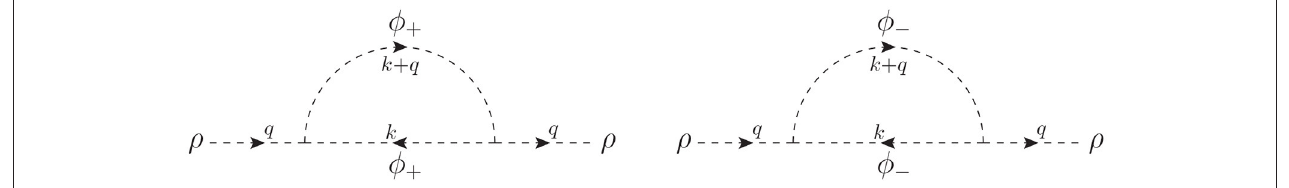
FIGURE 1 | One-loop contributions to the self-energy of the scalar ρ in the physical basis, corresponding to the Lagrangian of Equation (6).